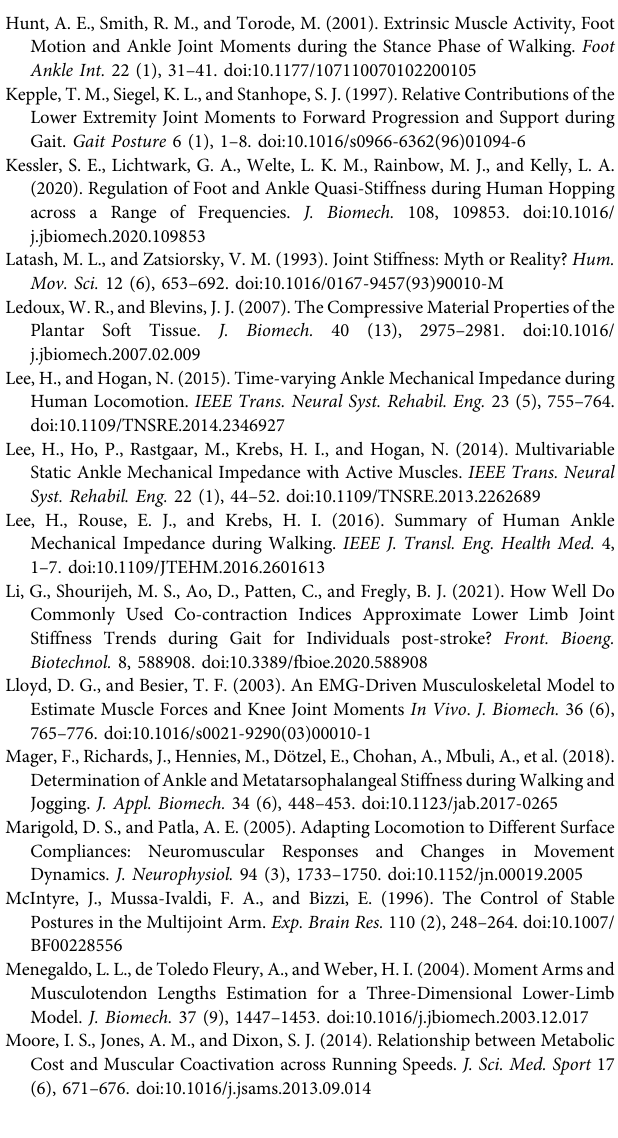
Supplementary Figure 1 | Stress – strain curves of three materials. Supplementary Figure 2 | Marker placements on body of subjects, modi fi ed based on the marker set of gait2392 model in